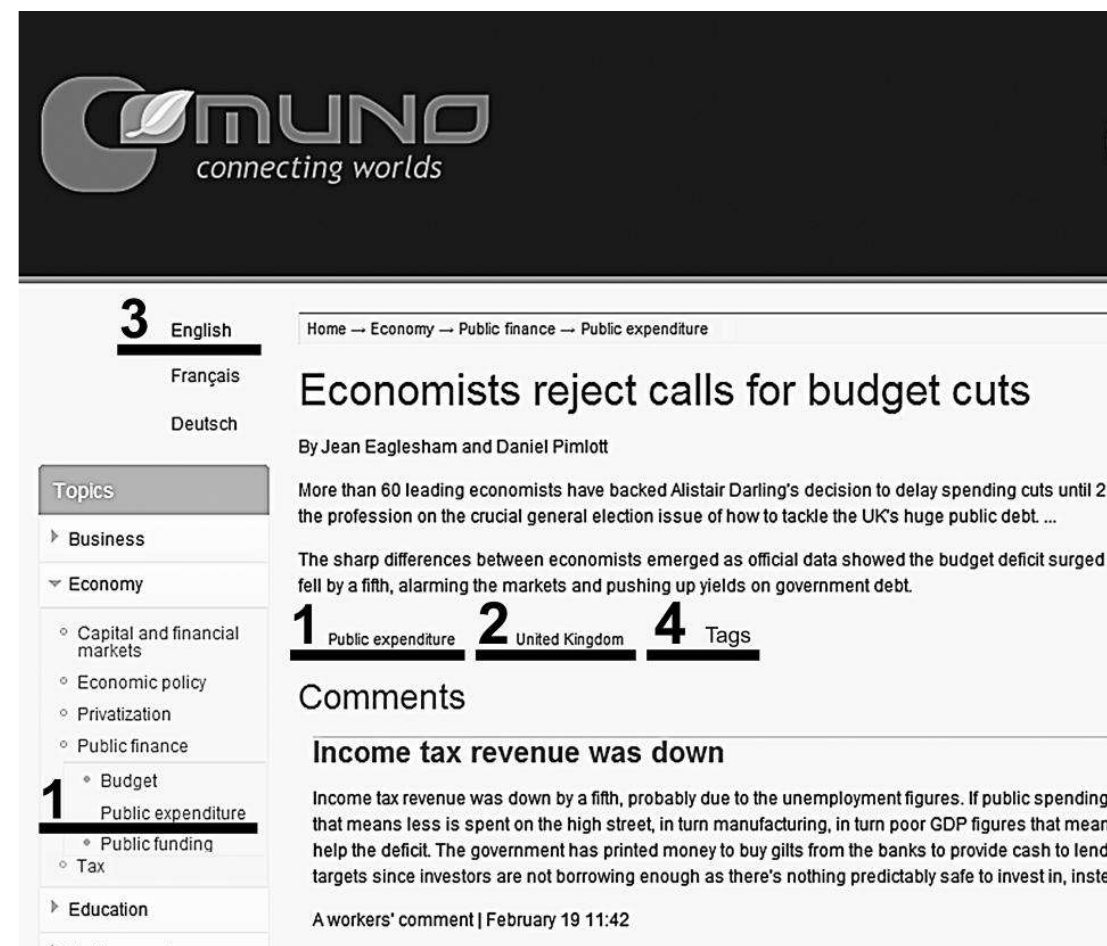
Figure 1: Interface elements displaying common semantics and